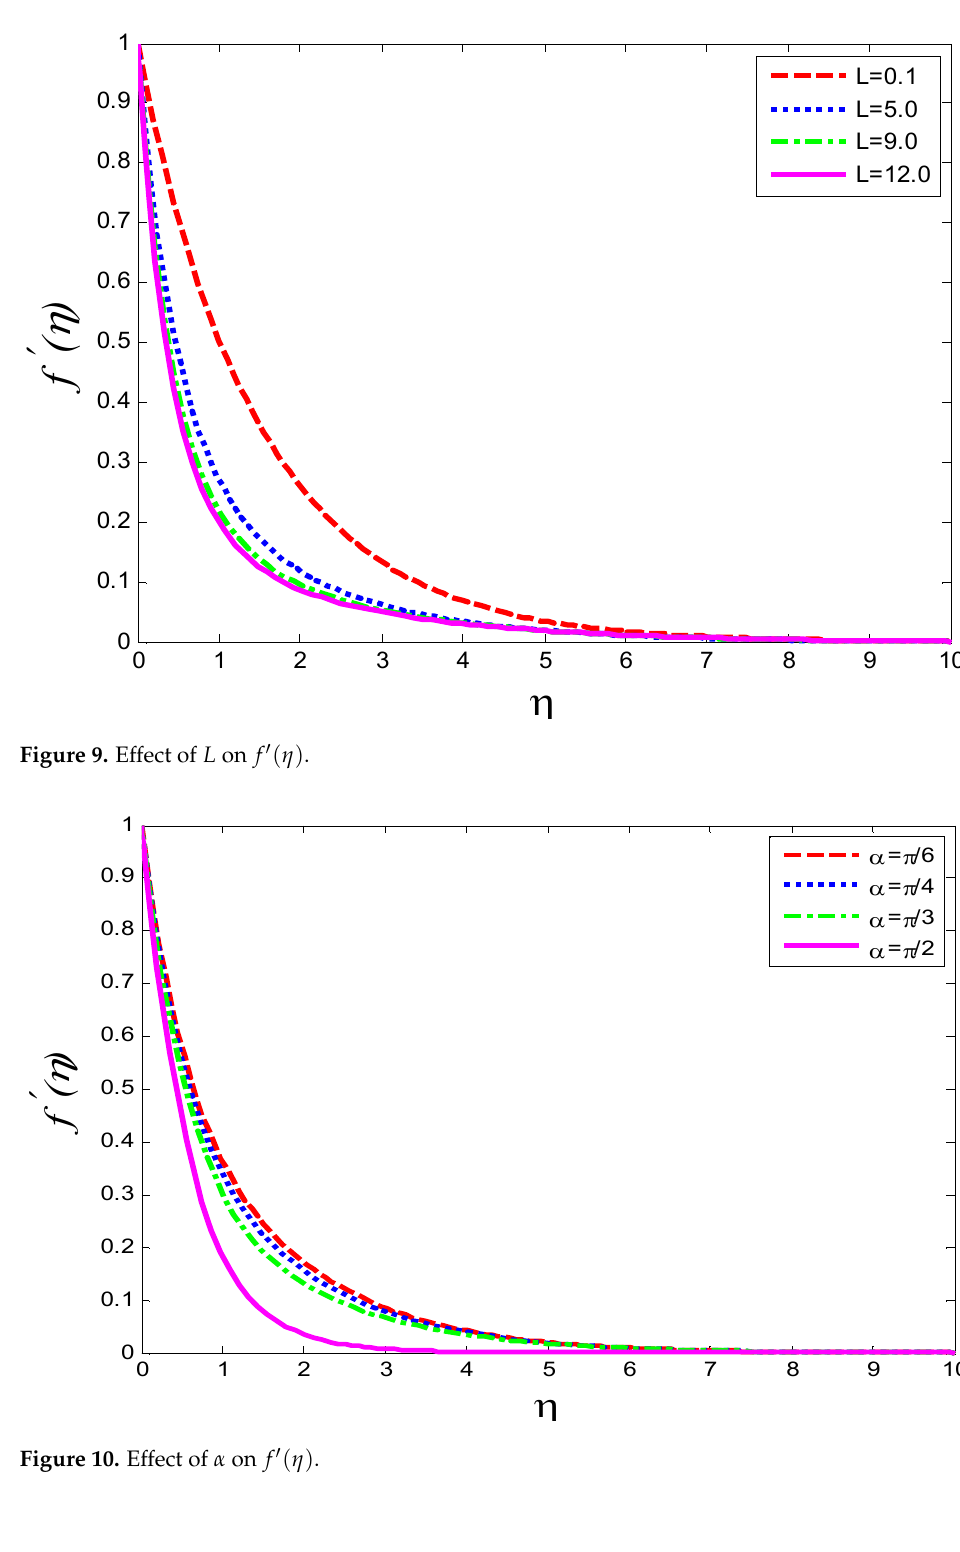
Figure 8. Effect of 𝛽 on 𝜙(cid:4666)𝜂(cid:4667) .